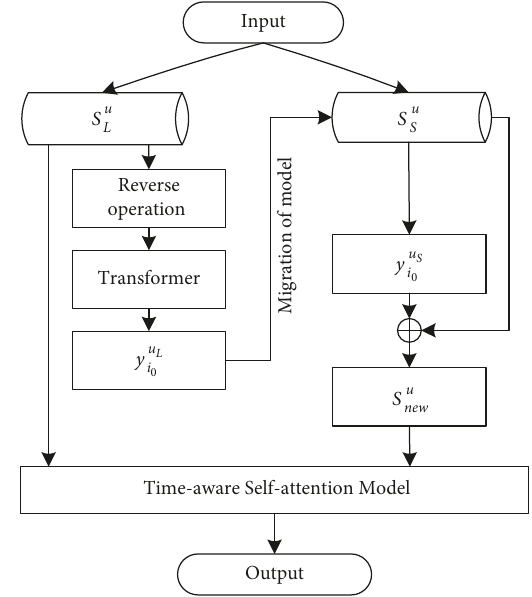
Figure 2: The framework of the proposed model, where S u resents the behavior sequence of the long-sequence user set U L ; S u S represents the behavior sequence of the short-sequence user set U S ; y u L i 0 represents the previous item of the item y u S i 0 represents the previous item of the item is the generated enhanced short and S u new